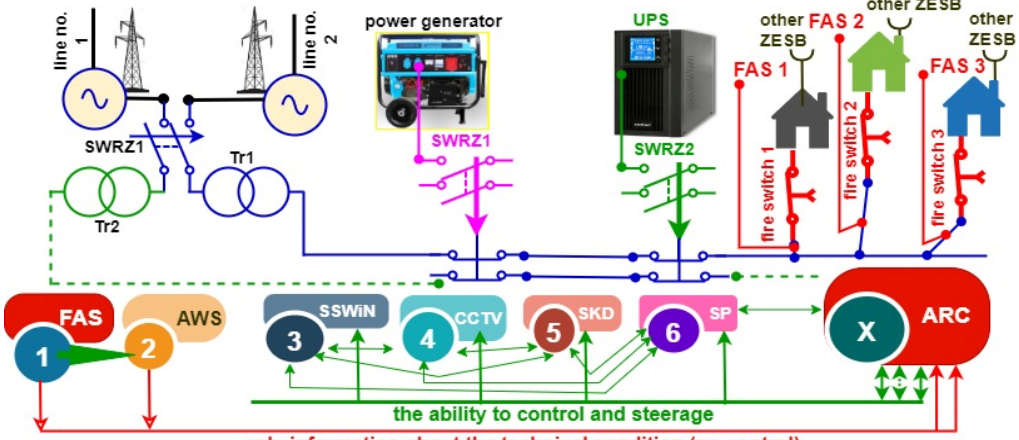
Figure 3. Power supply for an IESS operated in SB and vast SCI area. Designation: SWRZ1, 1, 2—automatic backup power switch; Tr1, 2—transformer stations; line no. 1, 2—power transmission lines 1, 2; UPS—uninterrupted power supply systems; FAS1, 2, 3—fire alarm systems used in individual buildings; other IESS (ZESB)—other ESS used in the buildings (supplied from an internal power line WLZ of the main cable connection, 1, 2, …, 6 ESB sequence by importance of security measures in SB and SCI areas; X—ARC supervision over an IESS (possible control and information exchange with individual ESB, most usually alarm control units (AWS, SSWiN-intrusion detection system, CCTV, SKD-Access Control Systems, SP-call system); or FAS—please note—only FAS → ARC information exchange).